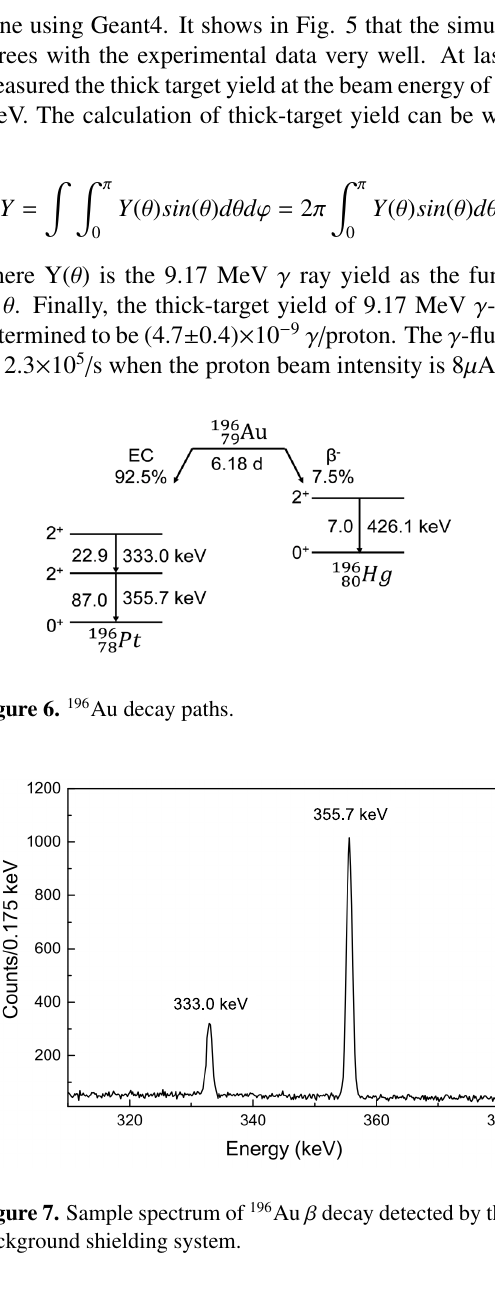
Figure 7. Sample spectrum of 196 Au β decay detected by the low background shielding system.